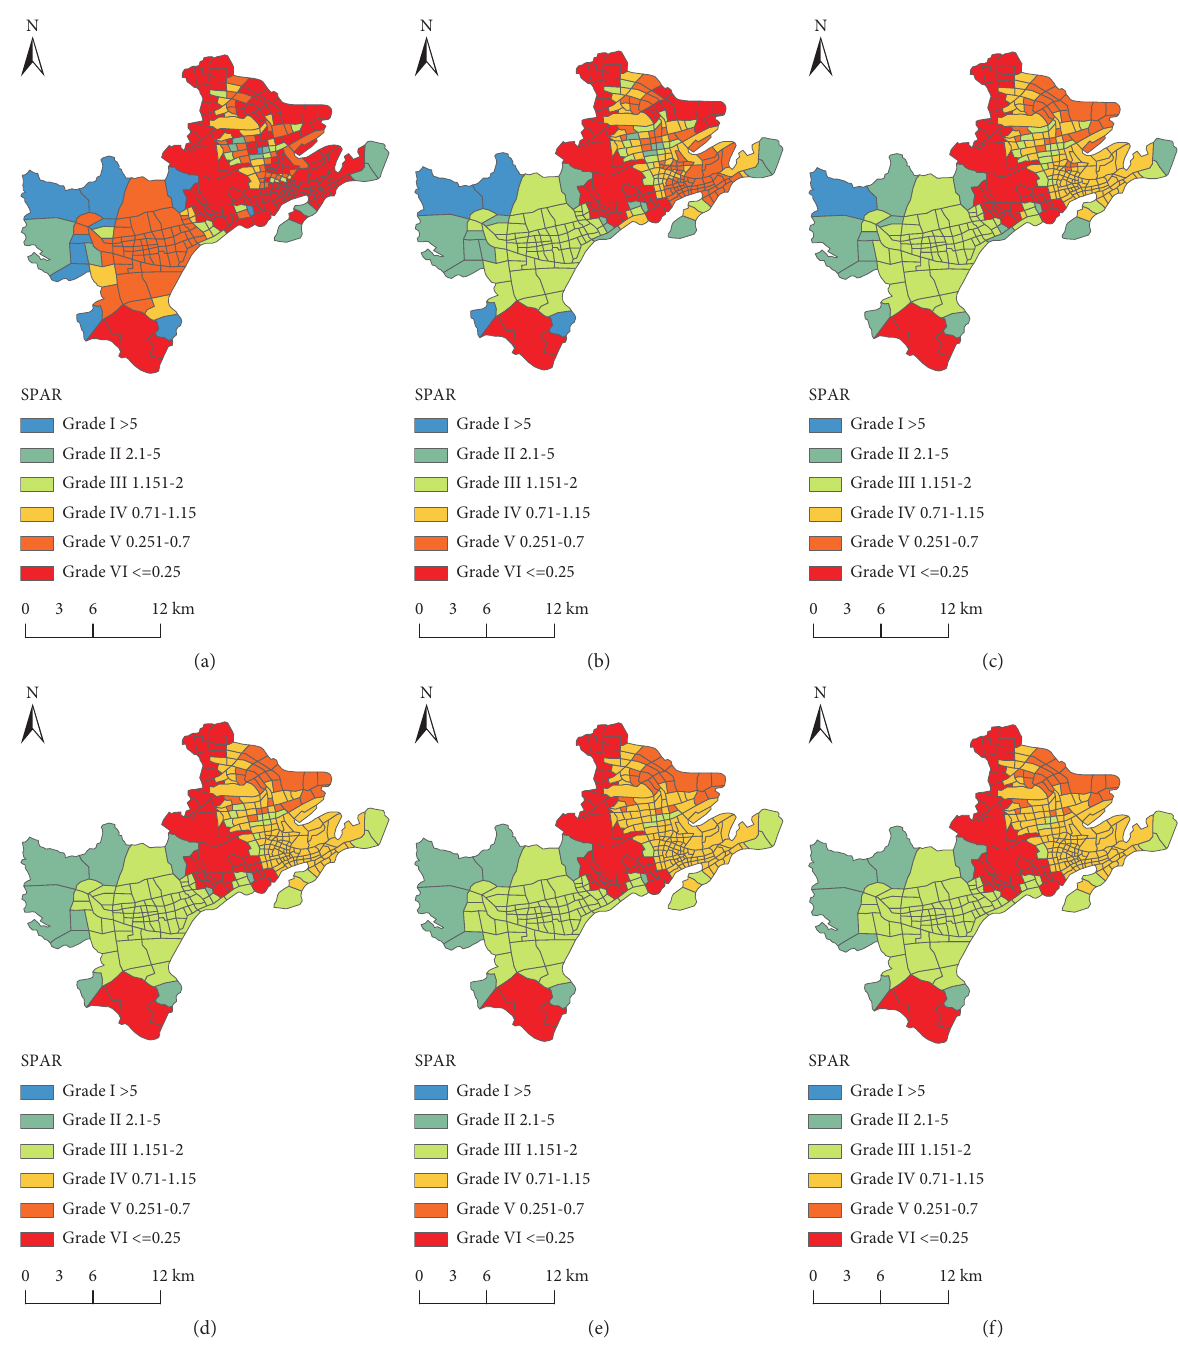
Figure 7: The geographic patterns of spatial access ratio (SPAR) with different impedance coefficients. (a) β � 10. (b) β � 25. (c) β � 40. (d) β � 55. (e) β � 70. (f) β �